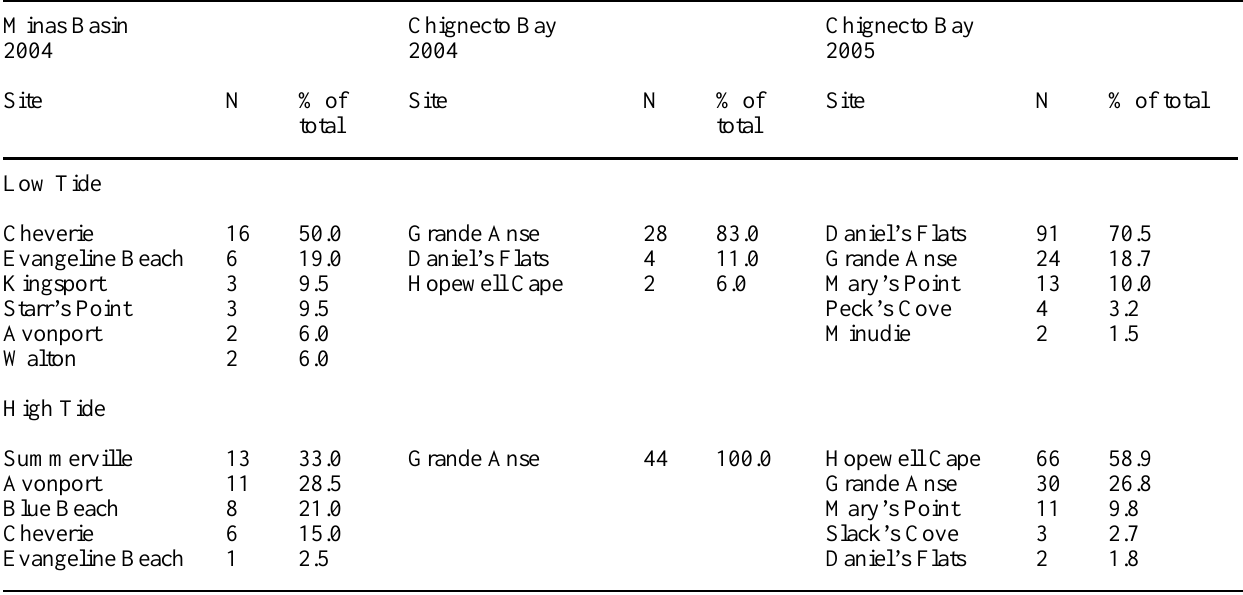
Table 1. Number and percentage of total radio-tracking detections for low tide and high tide during each site and year